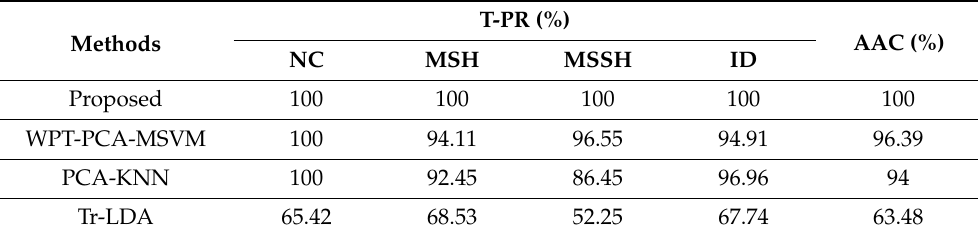
Table 3. Performance of the proposed method and reference